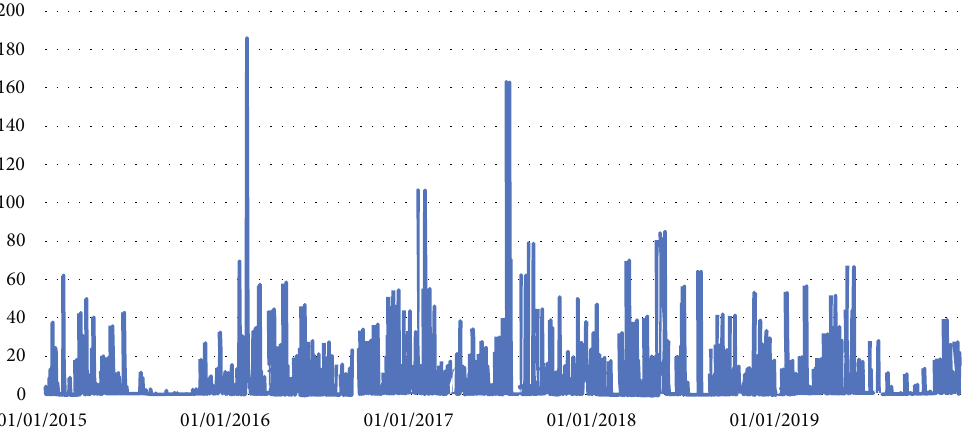
Figure 4: Daily rainfall in the study area.